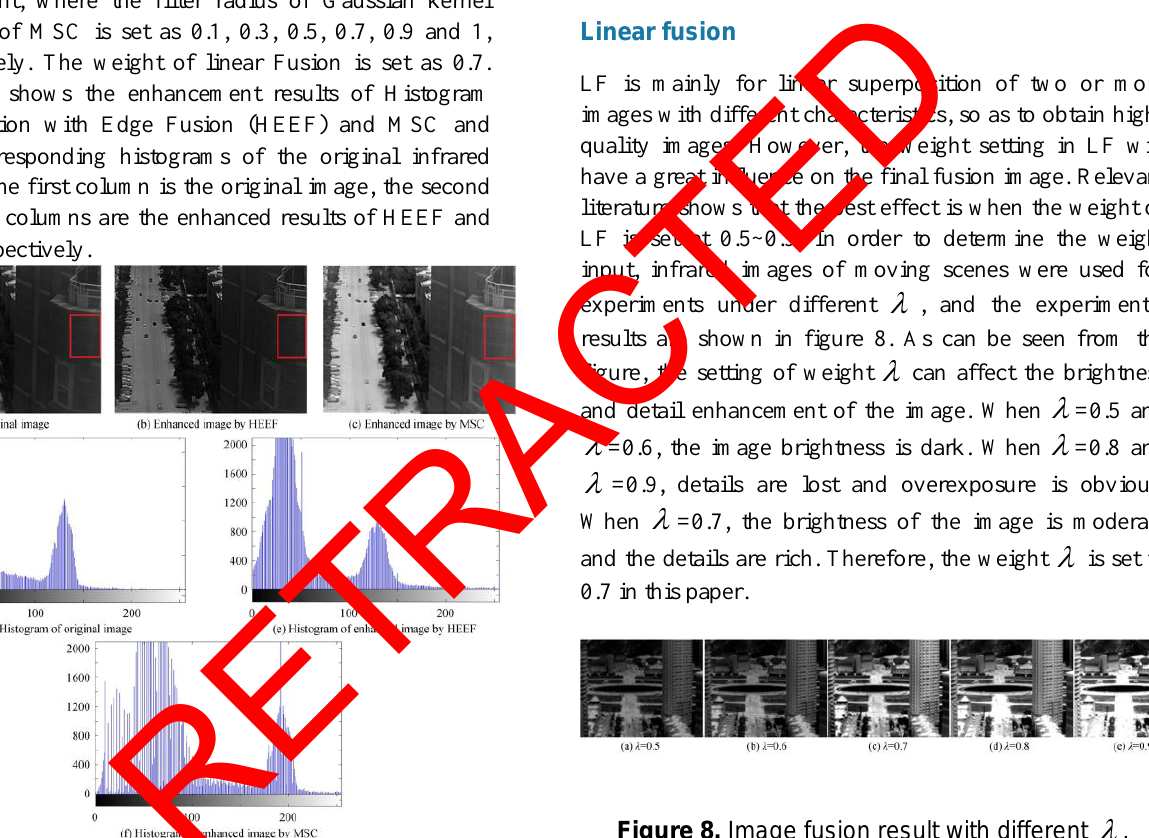
Figure 8. Image fusion result with different 